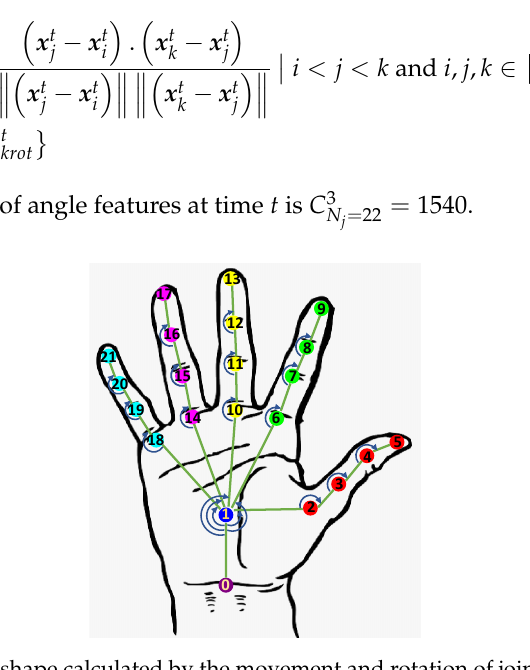
Figure 4. Hand skeleton shape calculated by the movement and rotation of joints with respect to their neighbors. There are 22 joints in the hand skeleton data numbered from 0–21: 0 (wrist), 1 (palm), 2–5 (thumb), 6–9 (index), 10–13 (middle), 14–17 (ring), and 18–21